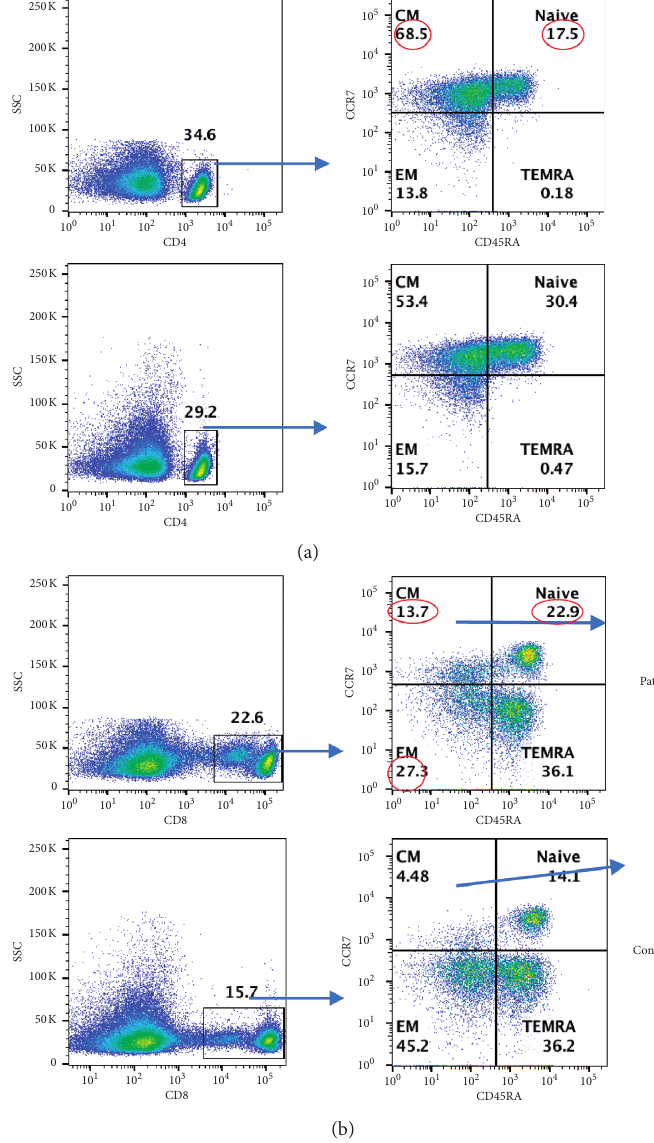
Figure 3: (a) CD4 subsets: CD4+ subsets are characterized by different makers; na ¨ ıve (TN; CCR7+CD45RA+) central memory: TCM (CCR7+CD45RA-), effector memory: TEM (CCR7-CD45RA-), Teffector memory RA: TEMRA (CCR7-CD45RA+). (b) CD8 subset: CD8+ gated cells. In PBMCs, CD88+ T cells were gated and gated CD8+ cells subsets are characterized by different makers: TN (CCR7+ CD45RA+), TCM (CCR7+CD45RA-), TEM (CCR7-CD45RA-), and TEMRA (CCR7-CD45RA+). Abnormal values are circled in